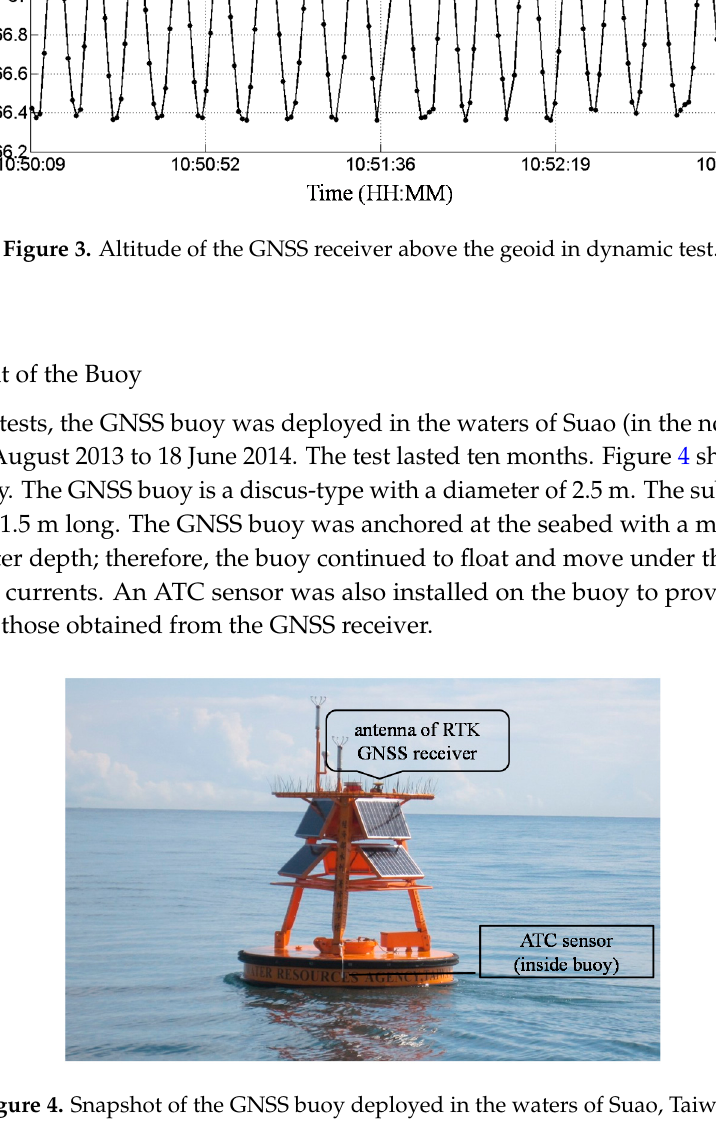
Figure 3. Altitude of the GNSS receiver above the geoid in dynamic test.